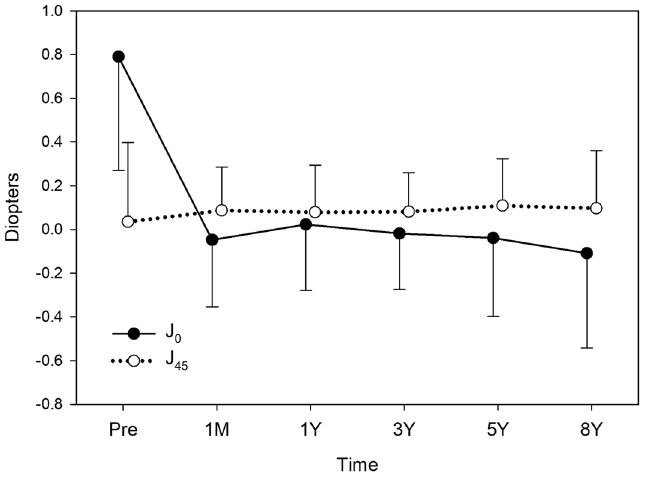
Figure 3. Time course of changes in astigmatism in eyes with preoperative with-the-rule astigmatism. Toric IOL implantation significantly decreased J 0 ( p < 0.001), but not J 45 ( p = 0.782). Postoperative values from 1 month to 8 years were not significantly different in J 0 ( p = 0.511) and J 45 ( p = 0.679).